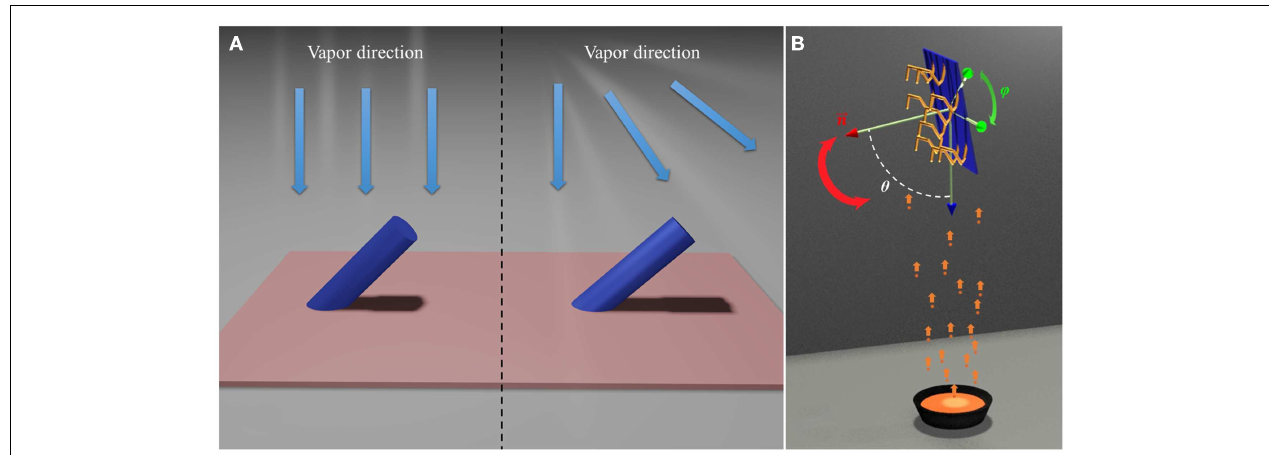
FIGURE 1 | (A) Self-shadowing effect: collimated parallel vapor beam (left) and divergent vapor beam (right). (B) The general deposition configuration of DSG.